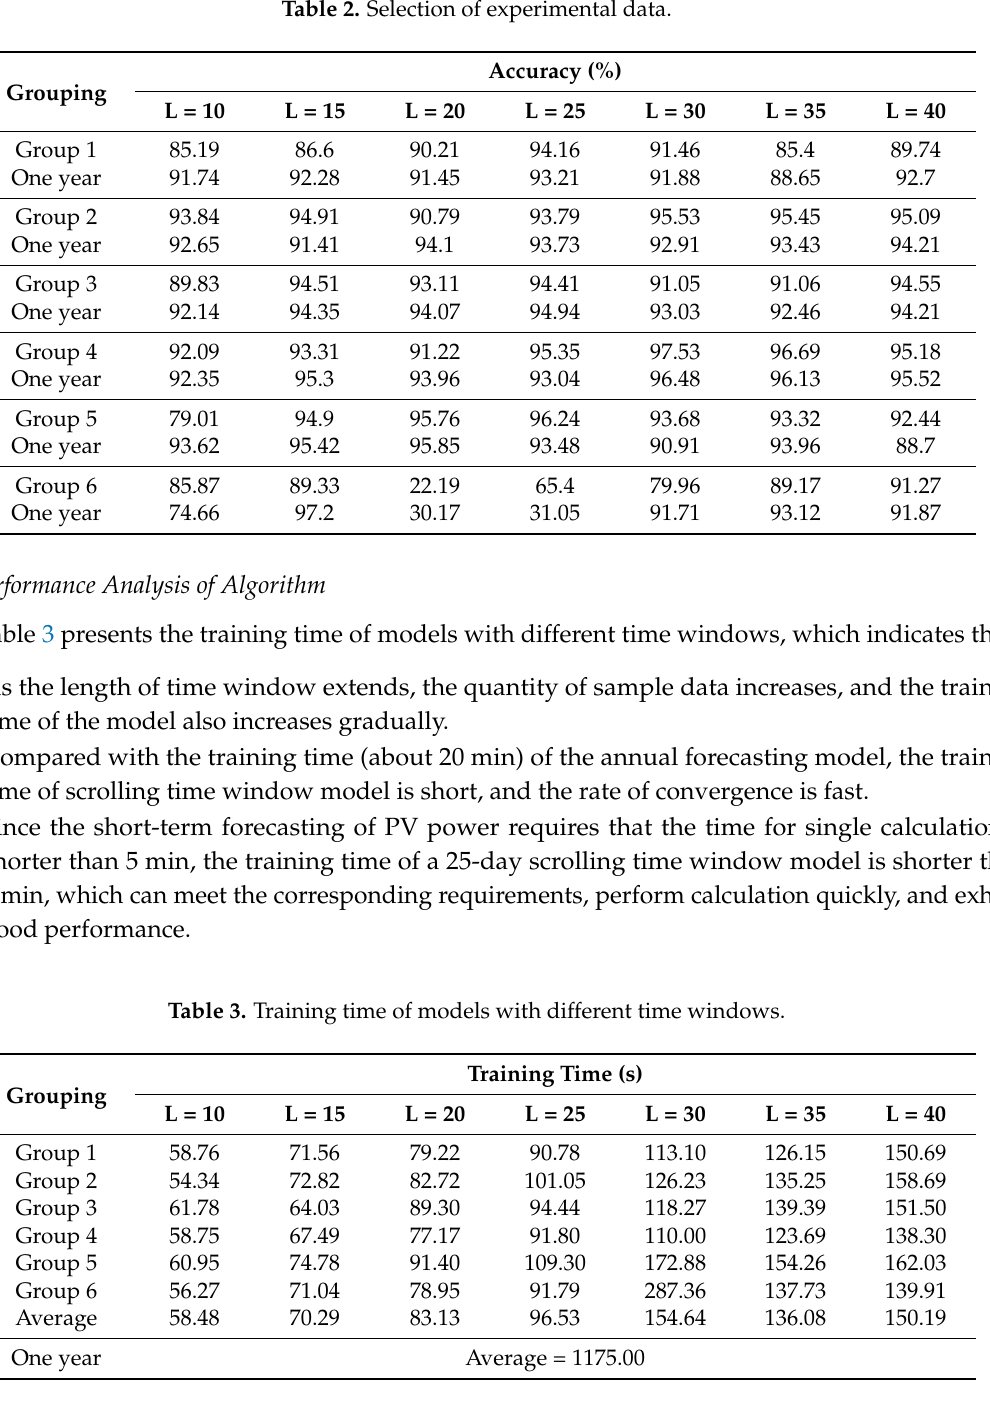
Table 2. Selection of experimental data.